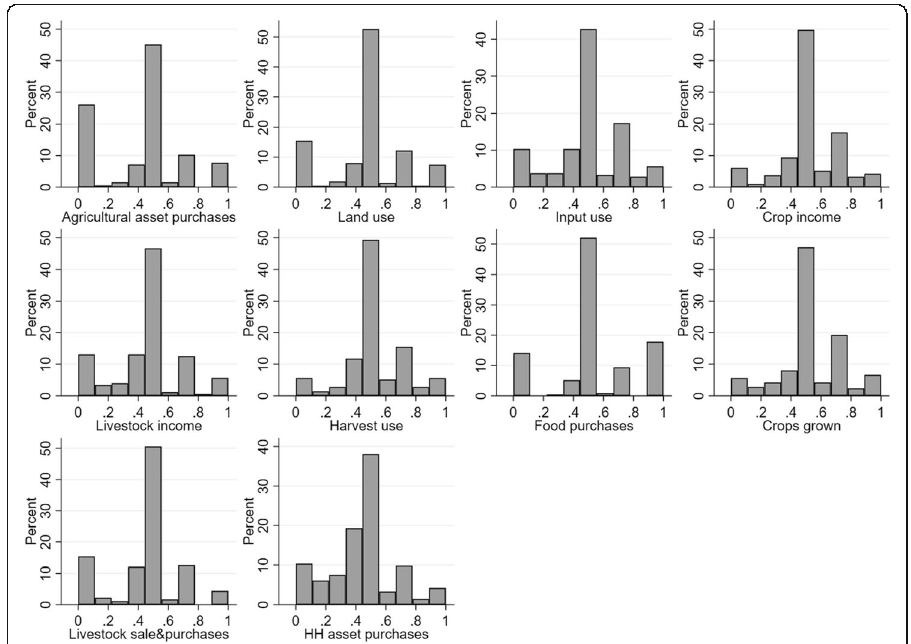
Fig. 2 Histograms of WPDM variables. Source: Authors ’